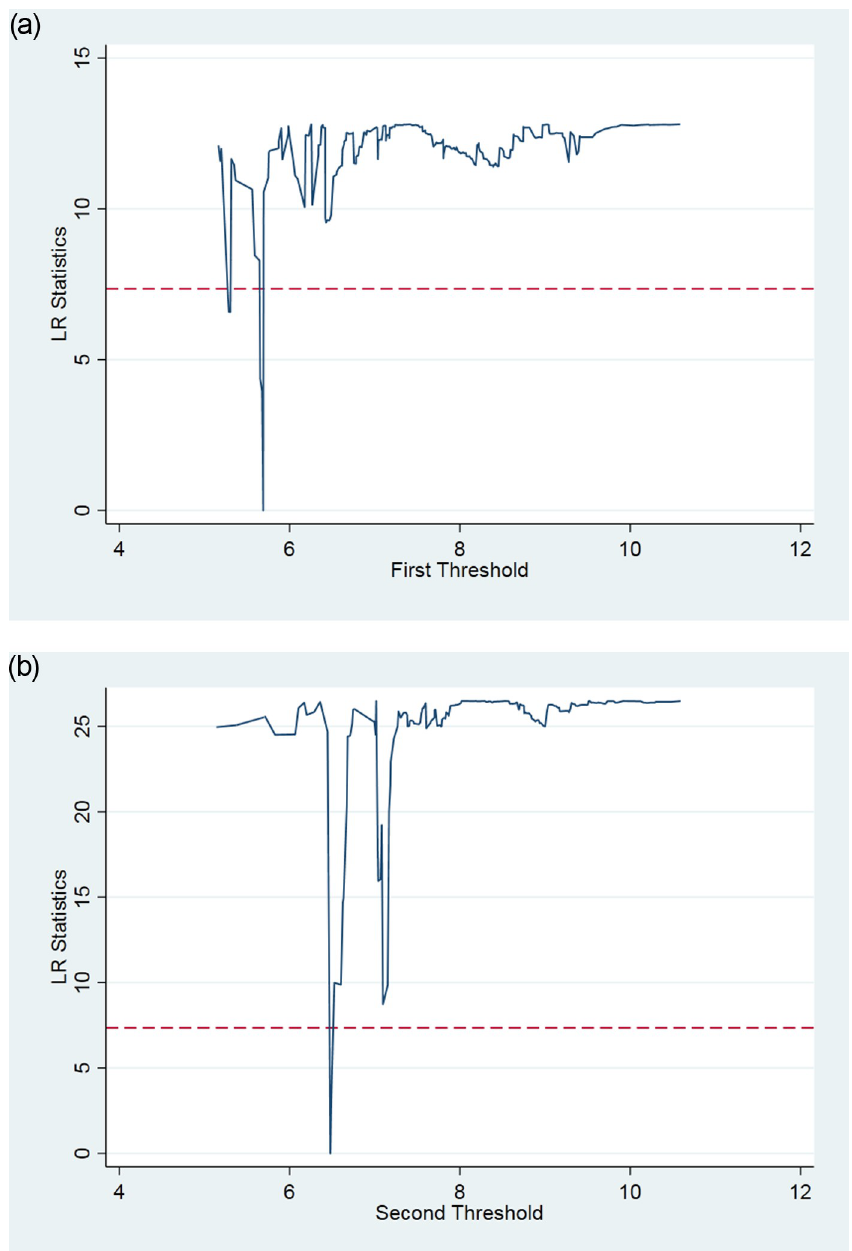
Fig 3. a. The LR map corresponding to the first threshold estimate of FDI quality. b. The LR map corresponding to the second threshold estimate of FDI quality.